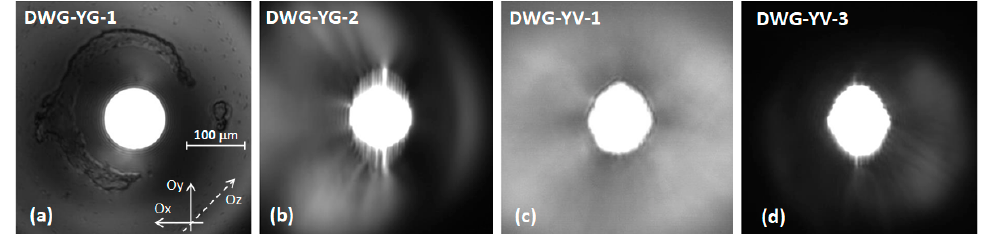
Figure 1. Photos of circular (100 μ m diameter) buried depressed-cladding waveguides inscribed in